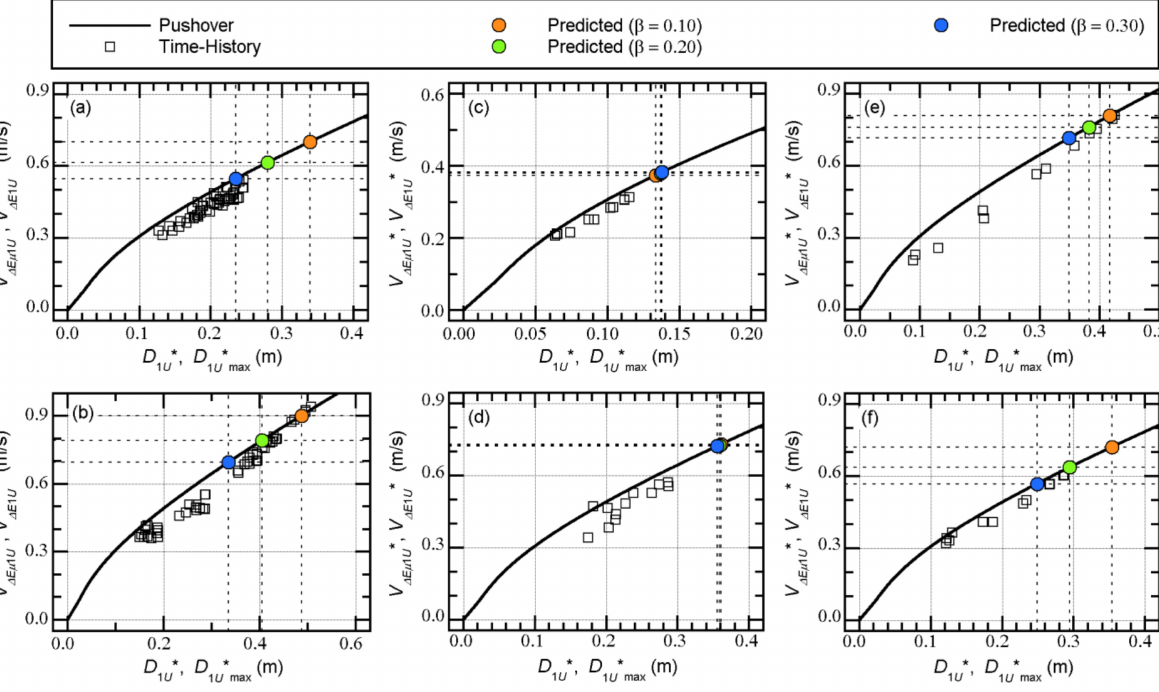
Figure 34. Comparison between the V ∆ E µ 1 U * – D 1 U * curve and the V ∆ E 1 U * – D 1 U * max relationship obtained from the time- history analysis (Model-Tf44): ( a ) Art-1 series; ( b ) Art-2 series; ( c ) UTO0414; ( d ) UTO0416; ( e ) TCU; ( f ) YPT.